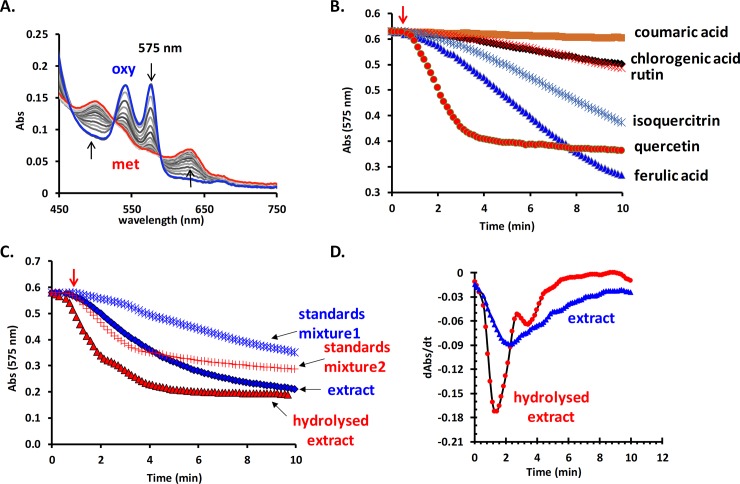
Evaluation of the pro-oxidant activity of the studied extract.The oxyHb (25 μM) is readily oxidized into met form in the presence of the extract (0.2 μg/mL final concentration) and laccase (100 nM) (A). Comparison between the prooxidant reactivity of the identified components of the extract all at the same molar concentration (5 μM) (B), their mixture in same ratios as in the extract prior hydrolysis (standard mixture 1) and after hydrolysis (standard mixture 2) and of the two analysed extracts (C). The comparison of the kinetic profile of the oxyHb oxidation in the presence of the two extracts and laccase depicted as first derivative of the measured curves (D).